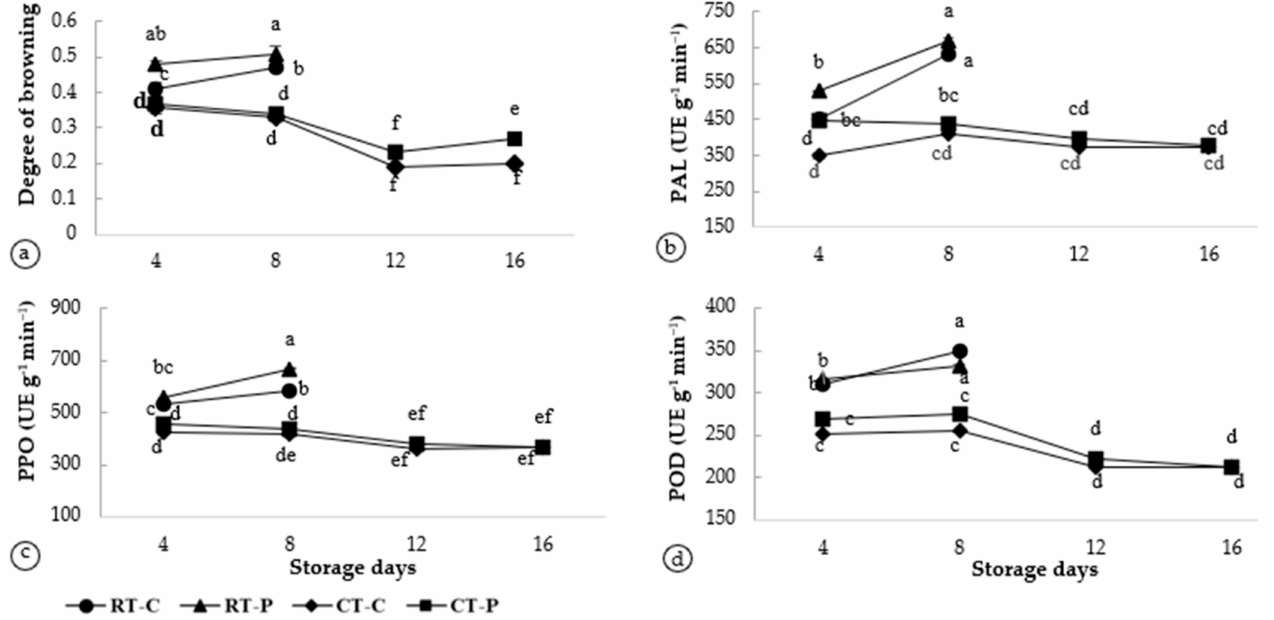
Figure 2. Enzyme activities associated with browning in Artocarpus odoratissimus fruit peel at different postharvest treatments. ( a ) Degree of browning, ( b ) PAL, ( c ) PPO, and ( d ) POD. Different superscript alphabets indicate differences at p < 0.05 (ANOVA, Tukey’s test. RT-C (room temperature and without packaging/control), RT-P (room temperature and with packaging), CT-C (cool temperature and without packaging/control), and CT-P (cool temperature and with